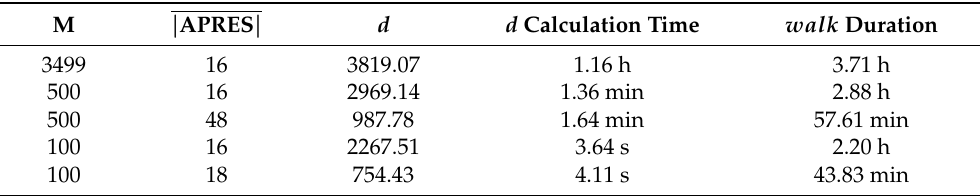
Table 3. Execution times for the calculation of d based on various input parameters, with network size = 7000. M —assumed malicious cluster size. Execution time was extrapolated from the average mainnet hop duration of 7 s and optimal d reduction at